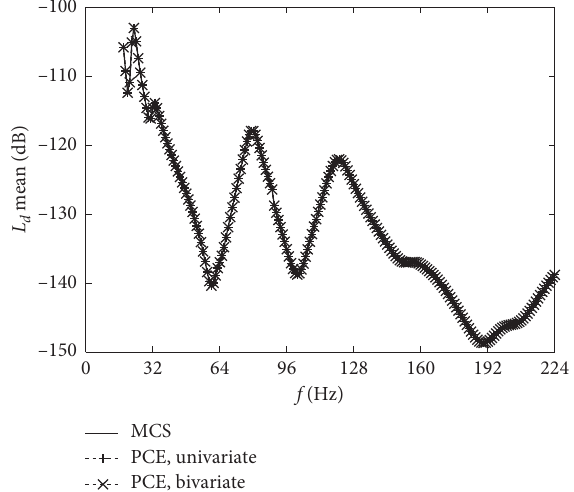
Figure 3: Mean of the dynamic compliance.